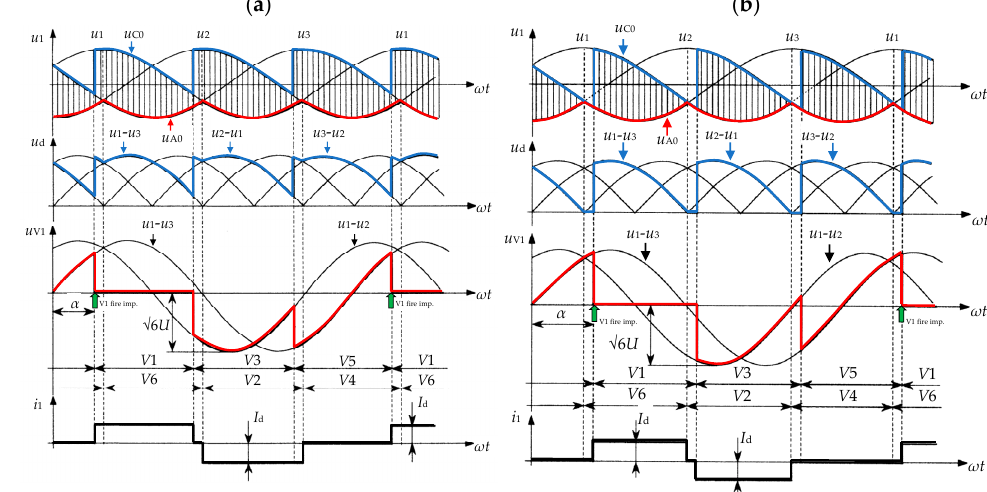
Figure 6. Typical waveforms of the mathematical model of a three − phase semiconverter with induc- tive load for ( a ) 𝛼 < 60° (six − pulse mode) and ( b ) 𝛼 > 60° (three − pulse mode).